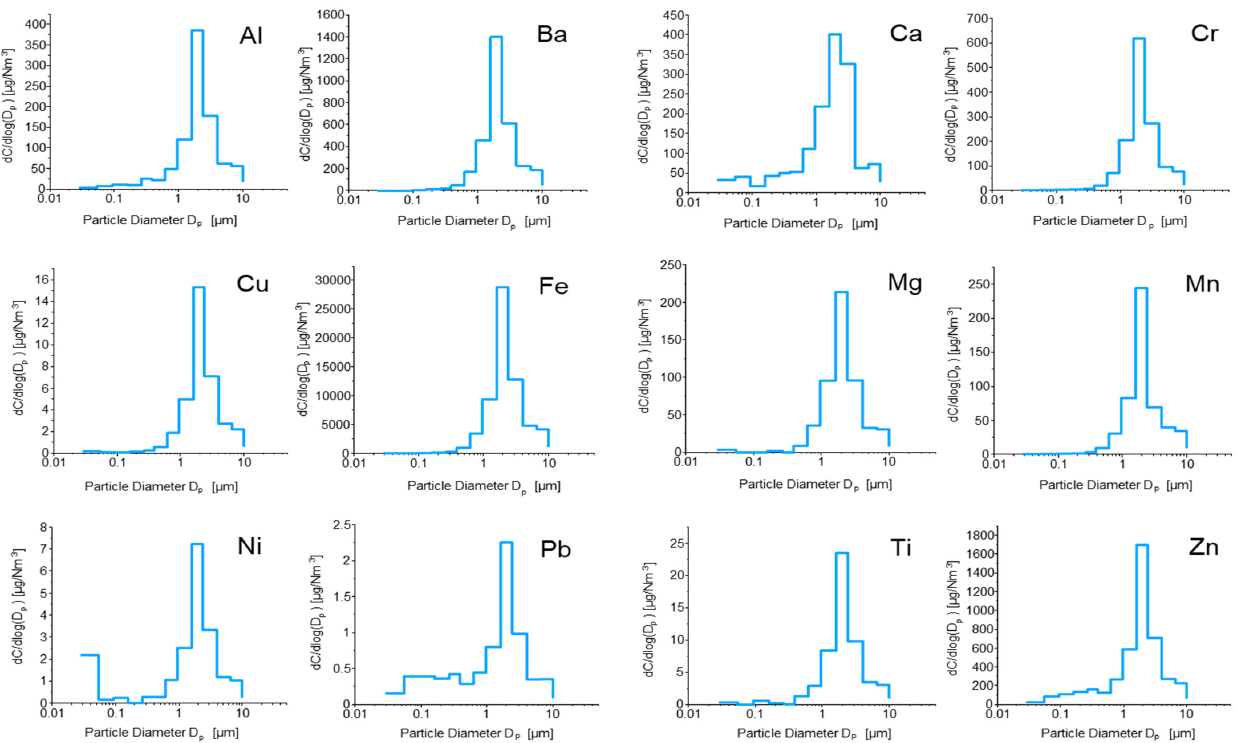
Figure 2. Size distribution of analytes over the 13 size fractions (oven digestion).